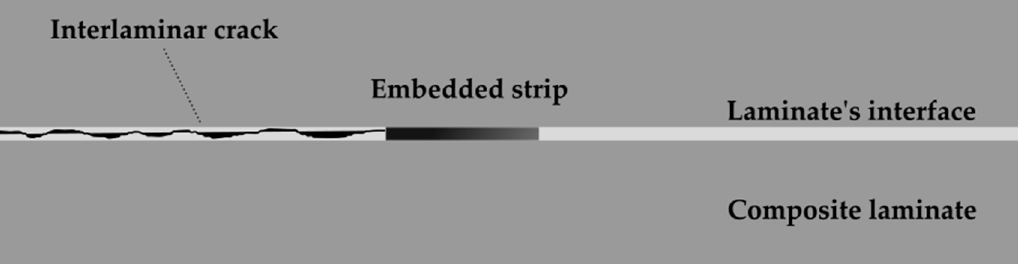
Figure 14. The embedded strip CAF concept. Table 1. List of literature findings based on the type of study, CAF and substrates’